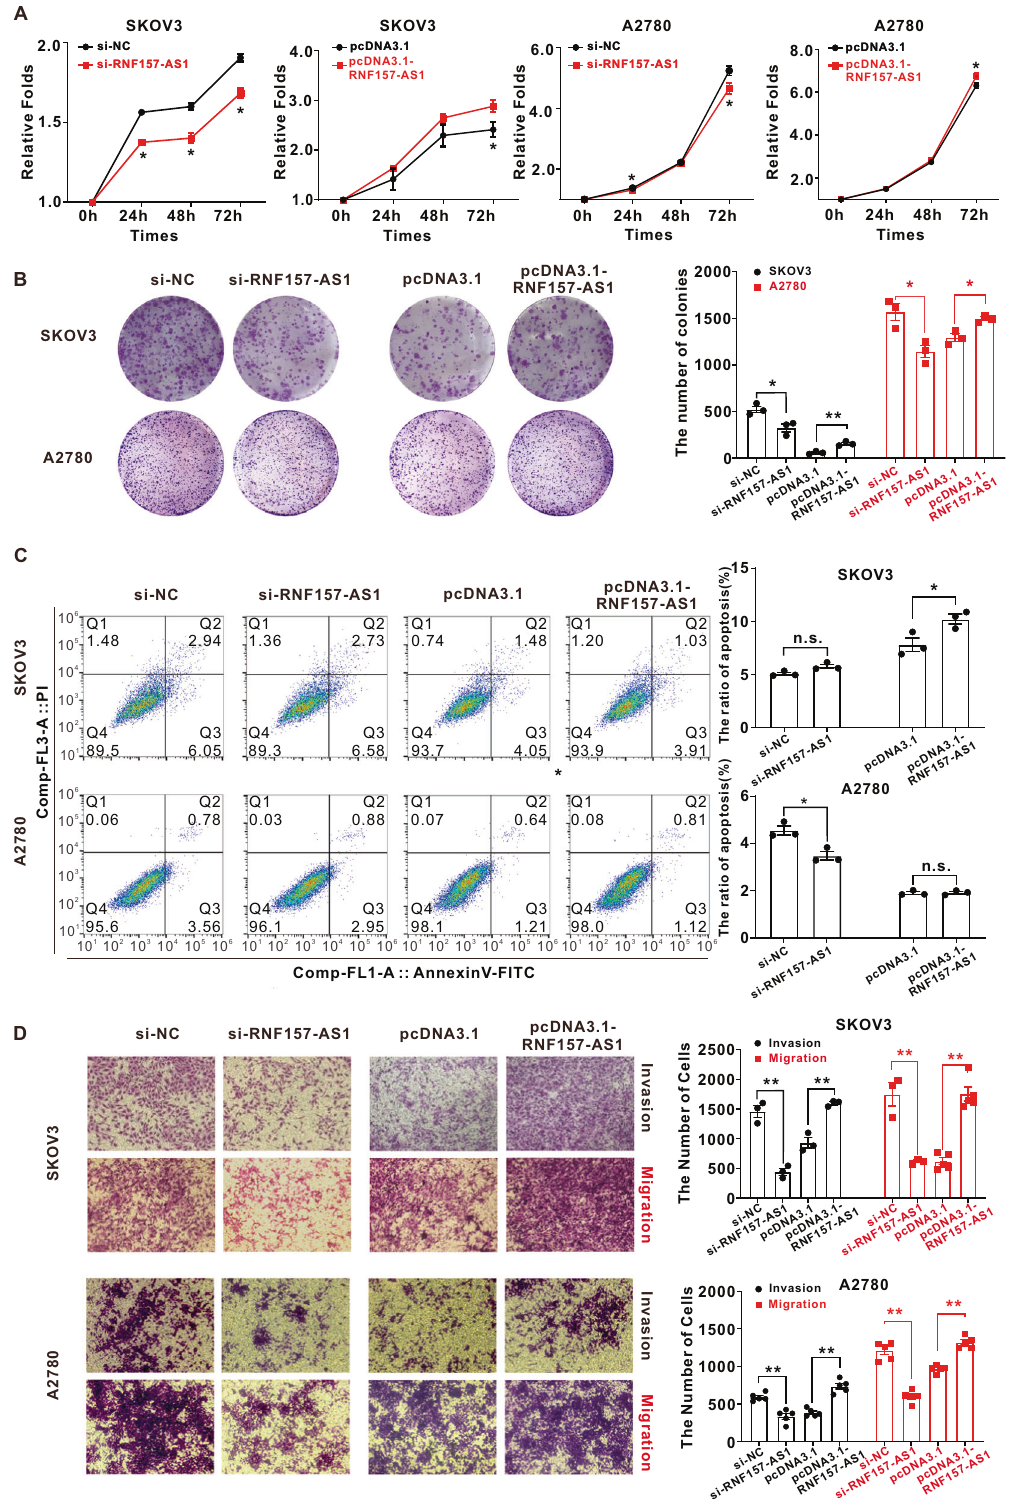
Fig. 2 The effect of RNF157-AS1 on EOC cell proliferation, apoptosis, invasion, and migration. A The CCK8 assay showed that RNF157-AS1 inhibition led to a signi fi cant decrease in the viability of SKOV3 and A2780 cells while RNF157-AS1 overexpression increased the proliferation rate of EOC cells. B The clone formation assay indicated that RNF157-AS1 knockdown signi fi cantly decreased the viability of SKOV3 and A2780 cells while RNF157-AS1 overexpression enhanced the proliferation of SKOV3 and A2780 cells. C The fl ow cytometry assay suggested RNF157-AS1 knockdown or overexpression had little effect on EOC cell apoptosis. D The transwell assay showed that RNF157-AS1 overexpression enhanced the invasion and migration of SKOV3 and A2780 cells but RNF157-AS1 depletion attenuated the invasion and migration of SKOV3 and A2780 cells. Data were obtained from at least three independent experiments. * P <0.05; ** P <0.01 ( t